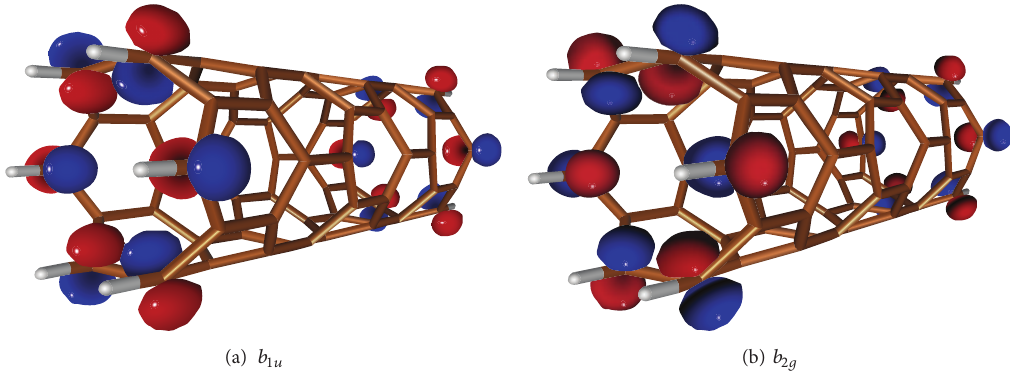
Figure 7: Active orbitals of nanotube 6 5 as an example of nanotubes with 𝑛 even and 𝑝